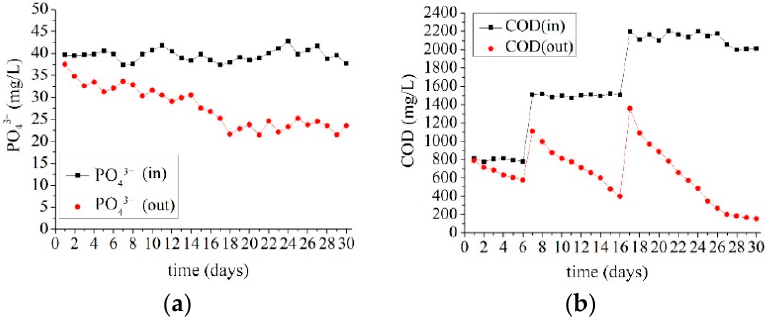
Figure 2. Change of carbon and phosphorus index in influent and effluent. ( a ) PO 43 − concentrations dissolved in water during start-up period. ( b ) COD concentrations during start-up period. y = 23.456x + 153.03 R² = 0.9926